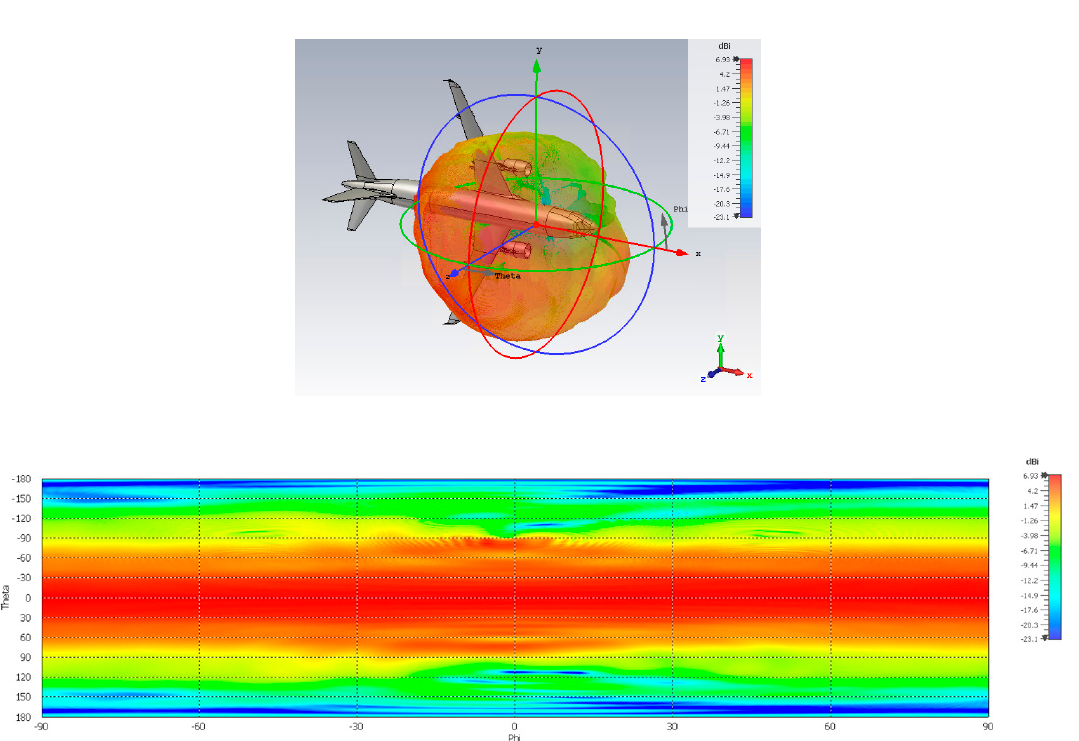
Figure 16. Coordinate Systems for both the GNSS results (elevation and azimuth) and e.m. simulations (phi and theta).